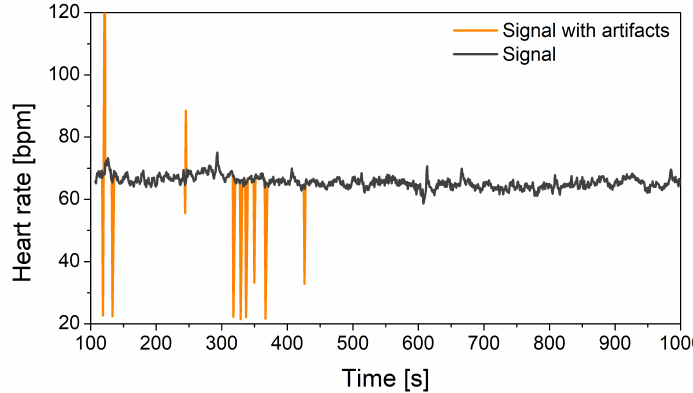
Figure 6. Heart-rate signal expressed in beats per minute (bpm) and typical artifacts. The heart rate was derived from the ECG signal recorded by TaskForce monitor at Bežanijska Kosa Hospital. The signal was recorded from a healthy volunteer who signed an informed consent about the participation in the experiment. The protocol was approved by the Ethics review board of the Medical Faculty, University of Belgrade. The artifacts were identified manually and replaced with the mean value of the nearest correct samples.